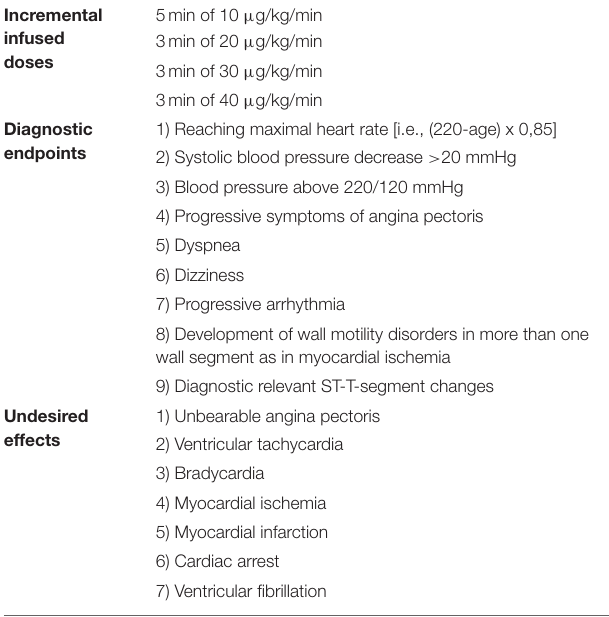
TABLE 4 | Dobutamine